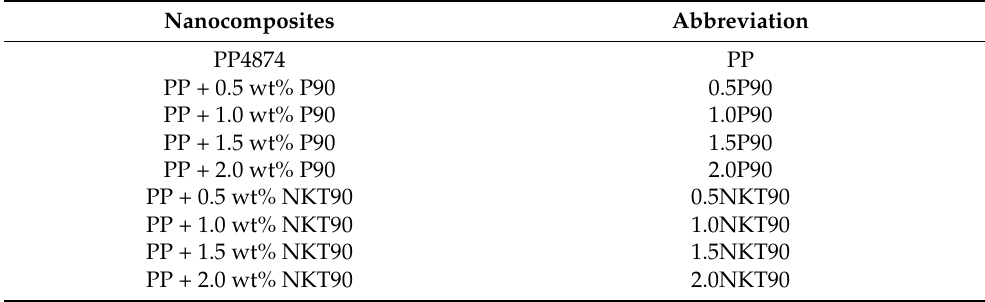
Table 1. Abbreviations for Borealis polypropylene 4874 and nanocomposites with 0.5 wt%, 1.0